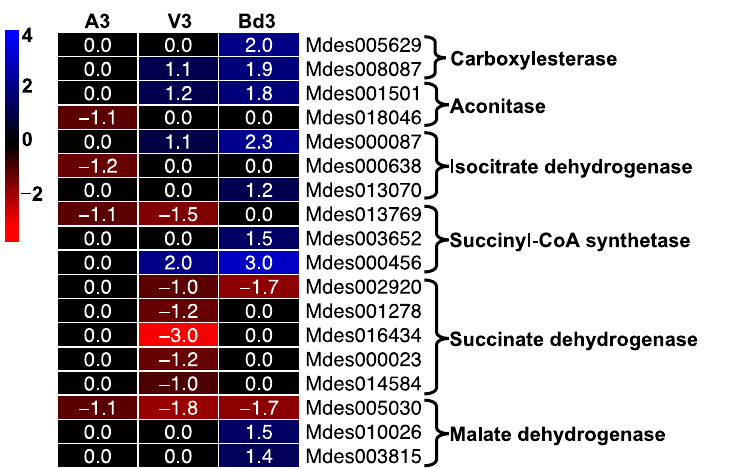
Figure 14. Regulation of genes from the tricarboxylic acid (TCA) pathway in Hessian fly larvae 3 days after hatch (DAH). Heatmap depicts changes in transcript levels of genes encoding enzymes of the TCA pathway in avirulent (A3), virulent (V3), and Bd3 larval transcriptomes. Log2 fold-change RNA-Seq values are shown within each cell of the heatmap. Blue represents up-regulated genes, and red represents the down-regulated genes, while genes not differentially expressed at a particular time-point are indicated in black.